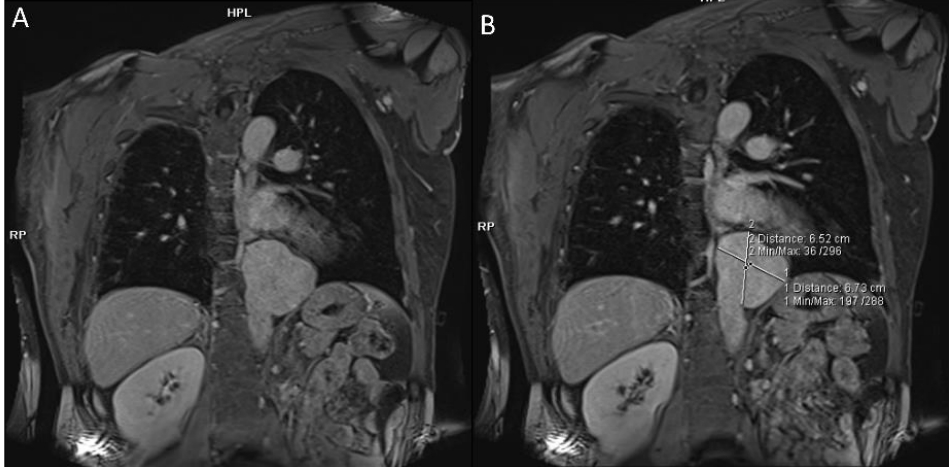
Figure 1. ( A , B ) Angio-MRI MIP reconstructions in BD patient that show aneurysm of thoracic aorta.